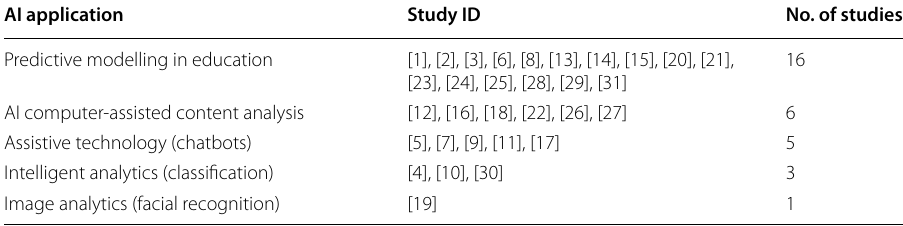
Table 2 AI applications in Latin America higher education across reviewed studies AI